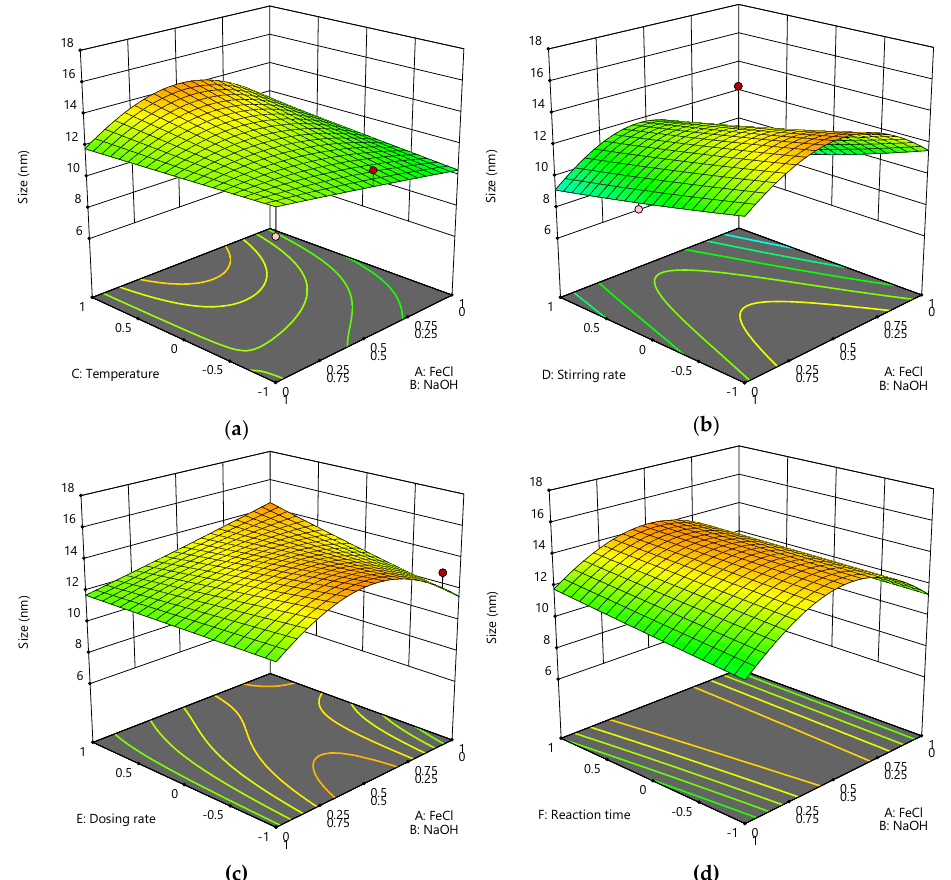
Figure 3. The predicted particle diameter (size) depending on temperature and iron salt / sodium hydroxide concentration while stirring rate and reaction time is maximal and dosing rate is minimal ( a ). The predicted particle diameter (size) depending on stirring rate and iron salt / sodium hydroxide concentration while temperature and reaction time is maximal and dosing rate is minimal ( b ). The predicted particle diameter (size) depending on dosing rate and iron salt / sodium hydroxide concentration while temperature, stirring rate and reaction time is maximal ( c ). The predicted particle diameter (size) depending on reaction time and iron salt / sodium hydroxide concentration while stirring rate and temperature is maximal and dosing rate is minimal ( d